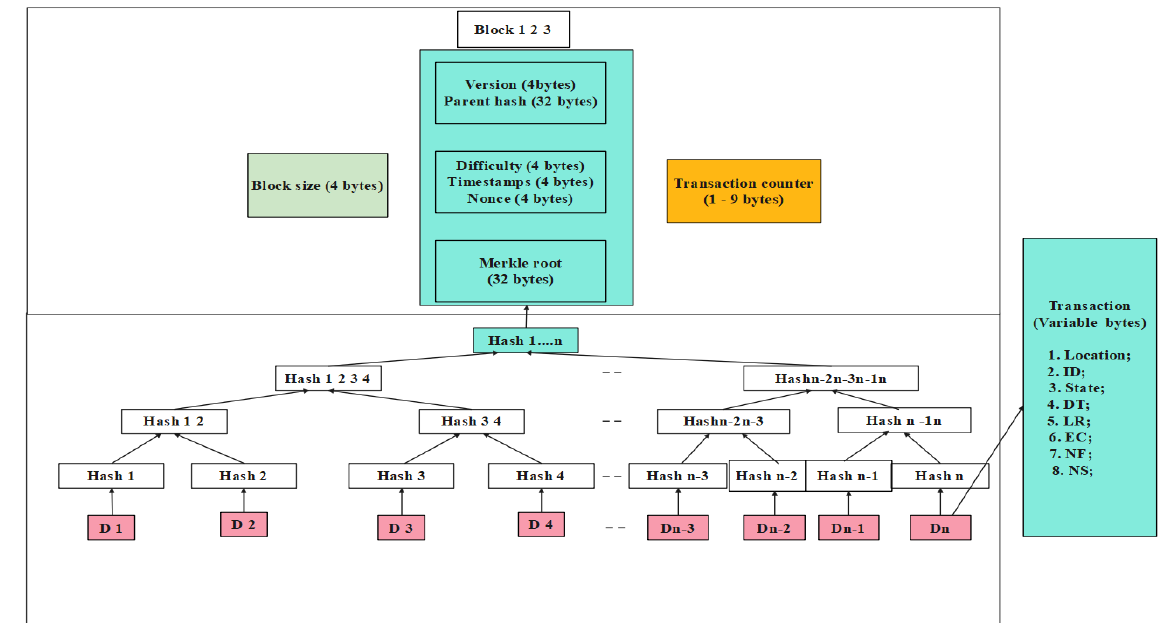
Figure 2. Data structure of blockchain for node detection.